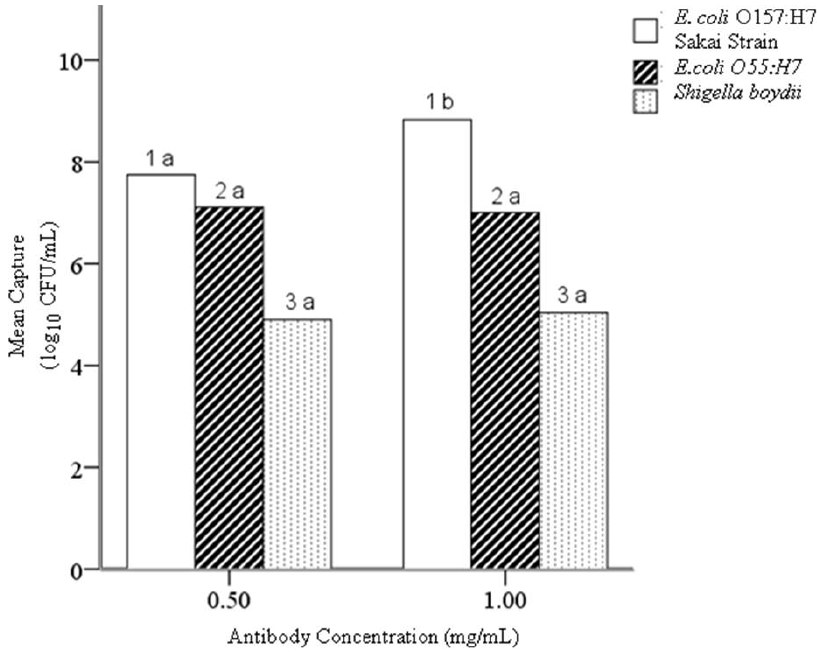
Figure 4. Mean concentration (log 10 of CFU/mL) of each bacterial culture captured in IMS, using Mab-EAMNPs made with 1.0 mg/mL antibody and with 0.5 mg/mL antibody. Statistical comparisons were made within numbered groups (1–3), and letters (a or b) indicate significant differences (α = 0.05, n =178, p = 0.018). Zero counts were estimated to facilitate analysis